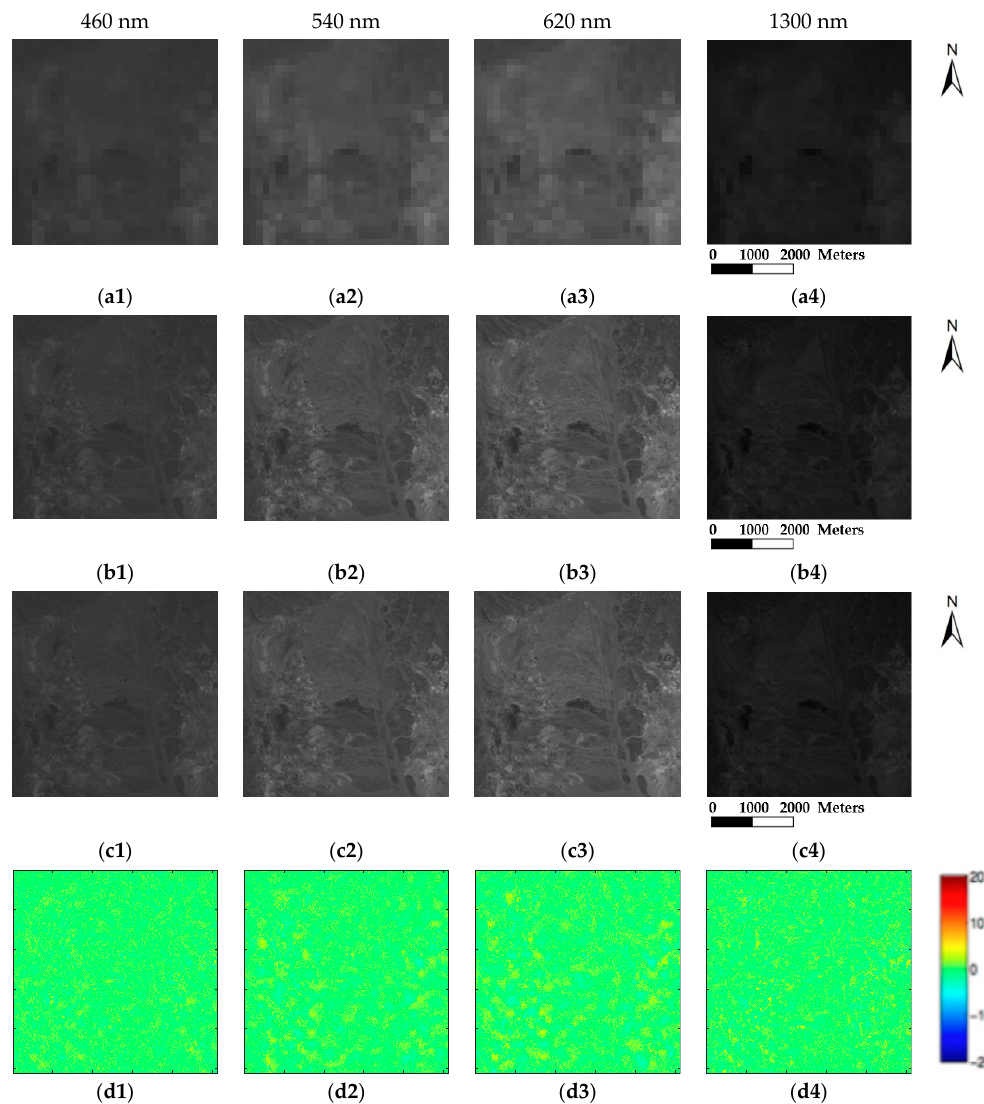
Figure 6. Fusion results of four single bands and error images of Image Cuprite: ( a1 – a4 ) LR-HSI; ( b1 – b4 ) Original HR-HSI; ( c1 – c4 ) Estimated HR-HSI; and ( d1 – d4 ) Error Image.